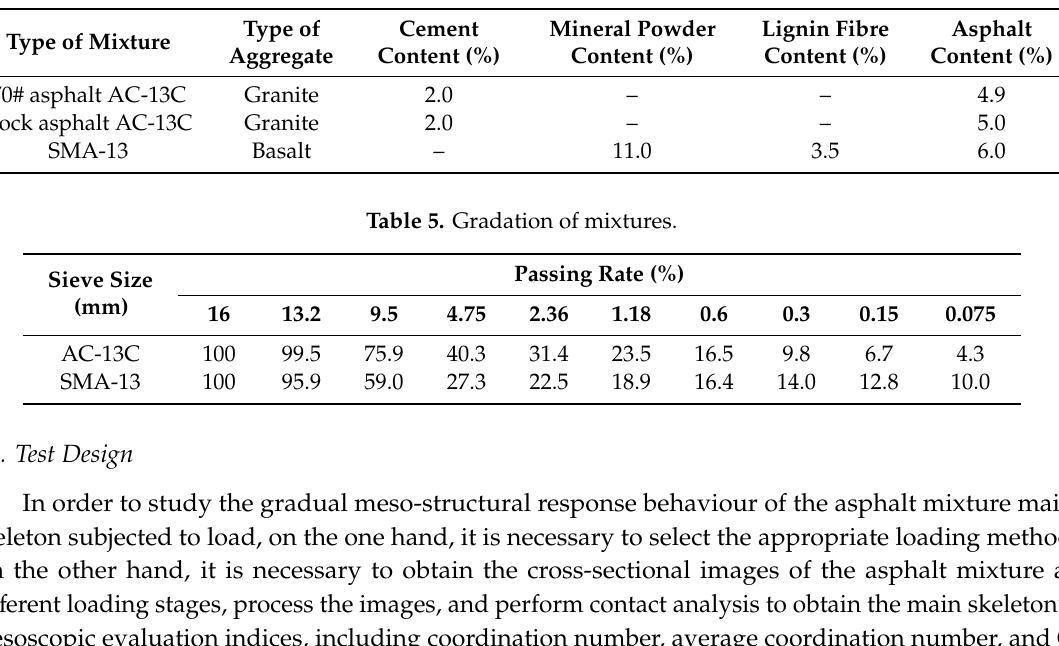
Table 4. Properties of additive dosages.